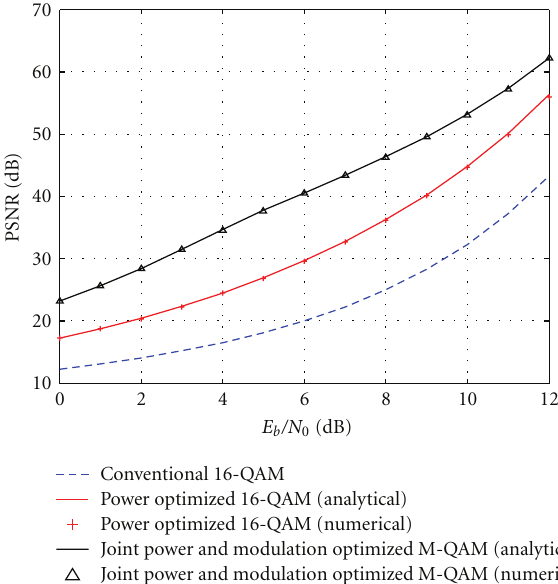
Figure 6: Comparison of PSNR performance in AWGN for analytical and numerical